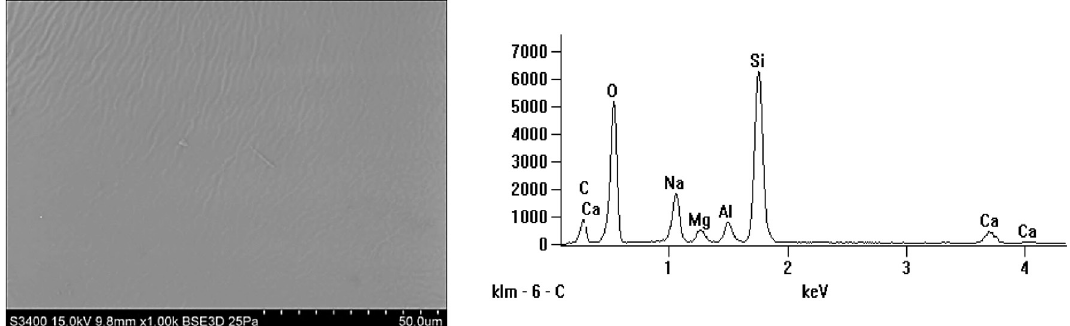
Fig. 2: Results of microstructure and EDS/SEM analysis of glass refined using aluminium hydroxide (WG) nano-particles